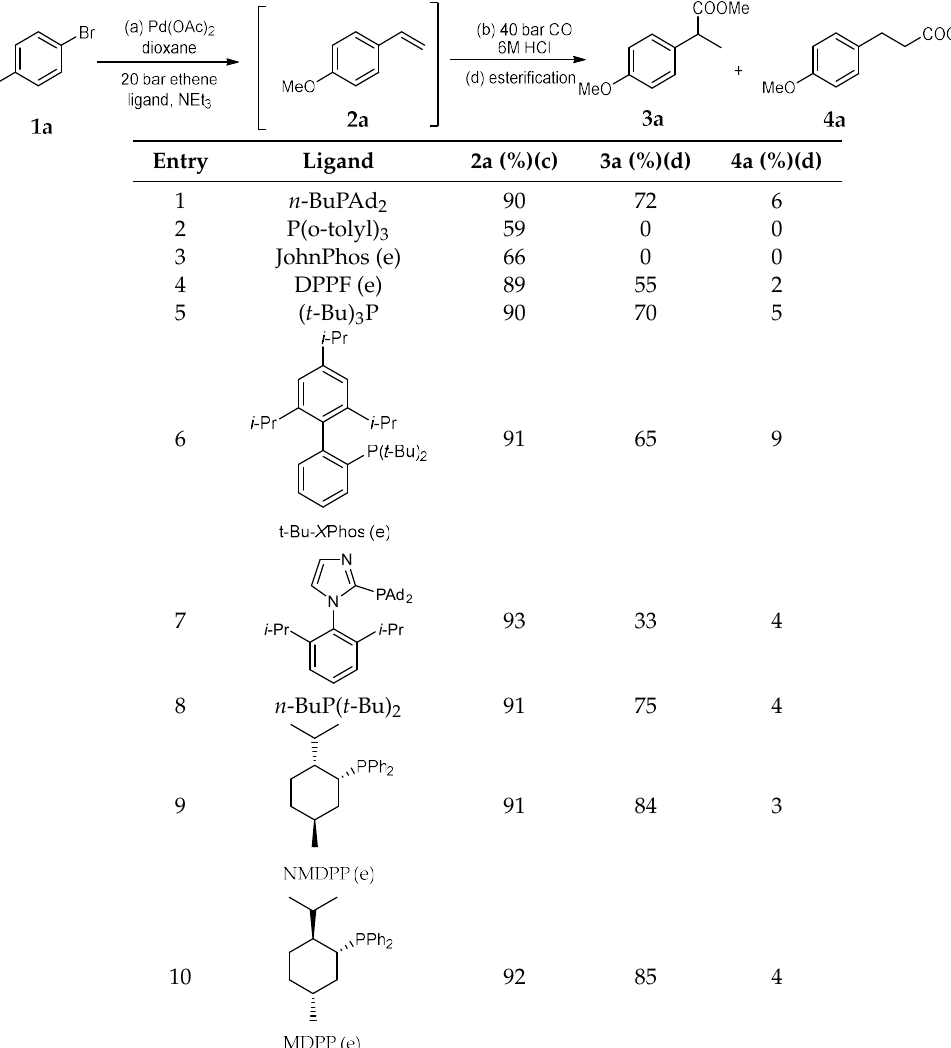
Table 1. Palladium-catalyzed two-step synthesis for 2-aryl propionic acid 3a .